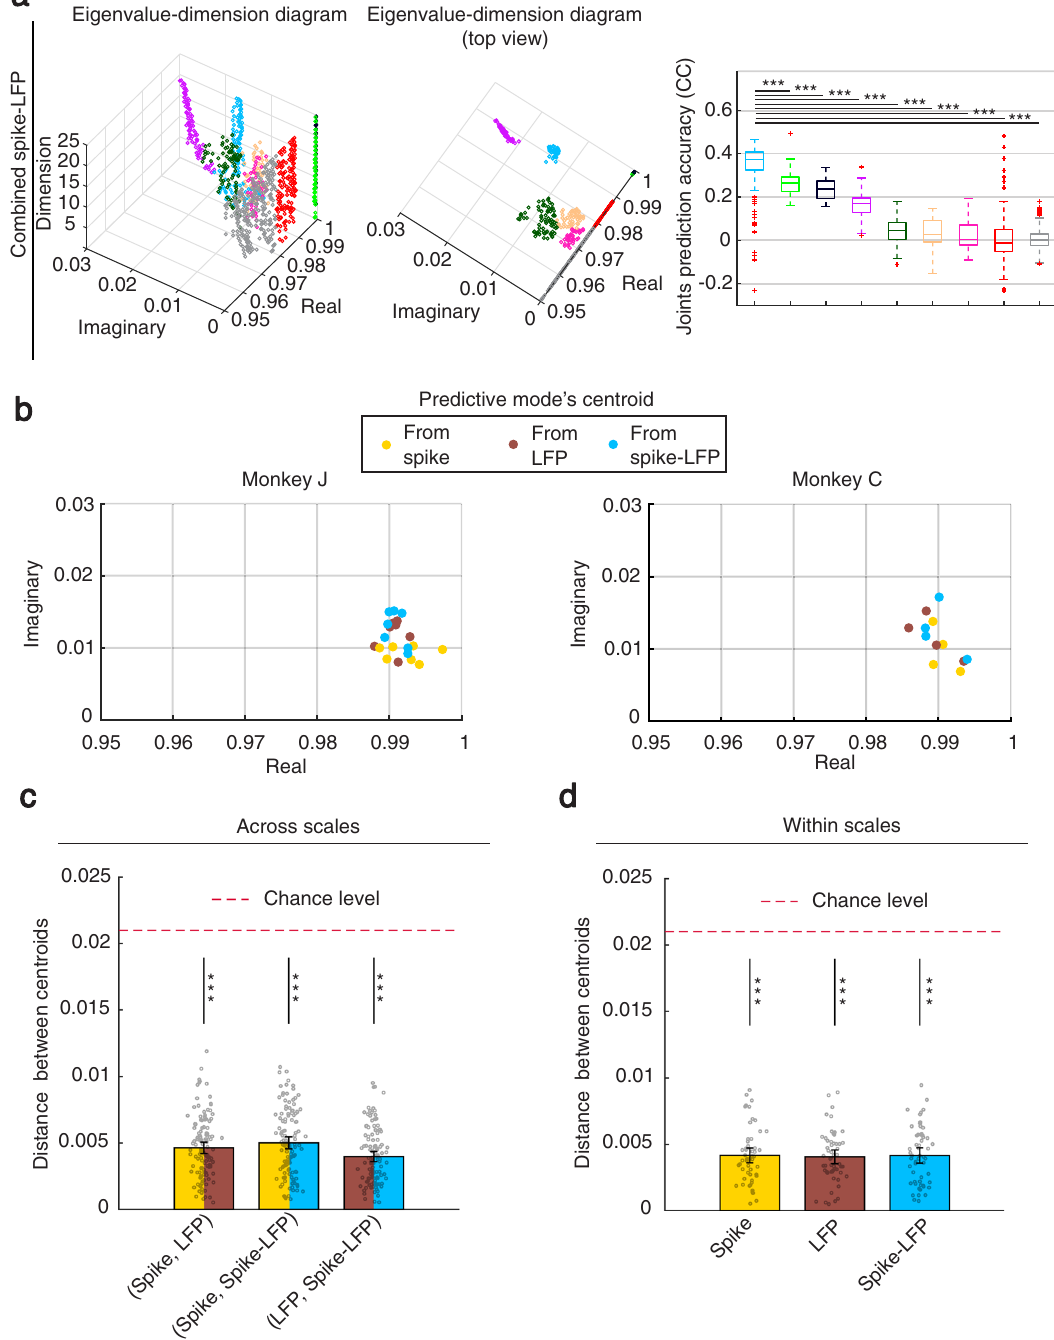
Fig. 5 The predictive mode is multiscale, i.e., is shared across scales of brain activity. a Eigenvalue-dimension diagram for combined spike-LFP activity. Figure convention is the same as Figs. 3 and 4. Combined spike-LFP network activity also exhibited several principal modes among which again one (cyan) was dominantly predictive of behavior ( P <3.4×10 − 12 , N s >125 cyan cluster members, one-sided Wilcoxon rank sum test). Boxplot outliers are a small fraction of data and mainly correspond to learned mode members at low dimensions when mode estimation has not converged yet. b The predictive modes across sessions in the two monkeys. Each dot represents the centroid of the predictive mode cluster in one experimental session for spiking (yellow), LFP (brown) and combined spike-LFP (cyan) network activity. c The location of the predictive mode was similar across scales of activity. The distance between the predictive mode centroids across scales, pooled across monkeys and experimental sessions was signi fi cantly smaller than chance-level ( P <6.8×10 − 22 , N s = 121 possible pairwise distances across scales, one-sided Wilcoxon signed-rank test). Each bar represents the mean of all possible pairwise distances between cluster centroids across scales shown in ( b ). For example, yellow-brown bar represents the mean of all pairwise distances between any yellow and brown dot in ( b ). Grey dots show all pairwise distances. Error bars show 95% con fi dence bound of the mean. Asterisks show the signi fi cance of comparison with chance-level distance with a similar convention as in Fig. 3. d The location of the predictive mode was similar across monkeys and experimental sessions ( P < 5.7 × 10 − 11 , N s = 55 possible pairwise distances within scales, one-sided Wilcoxon signed-rank test). Same as ( c ) but for pairwise distances between cluster centroids within scales in ( b ). For example, yellow bar represents the mean of all pairwise distances between any two yellow dots in ( b ). Source data are provided as a Source Data fi